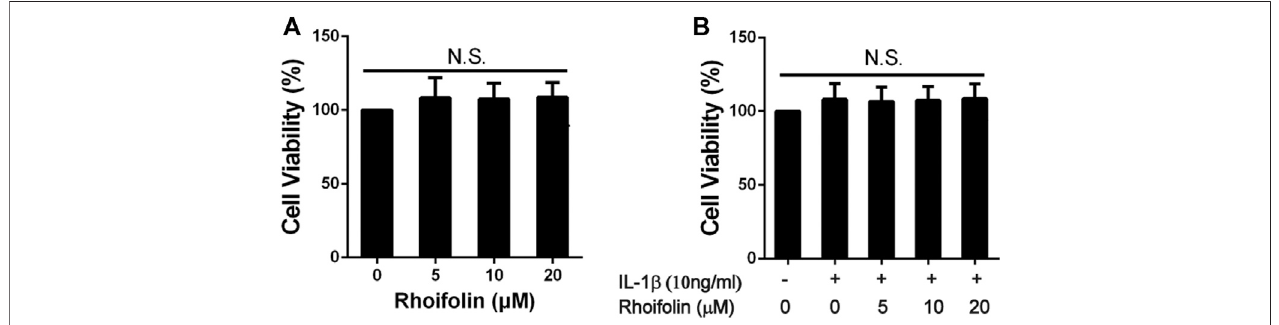
FIGURE 1 | Effects of ROF on Cell Viability. (A) Rat chondrocytes were exposed to ROF (5, 10, 20 μ M) alone or (B) with IL-1 β (10 ng/ml) for 24 h and cell viability was assessed by CCK-8 assay. N.S. indicated no signi fi